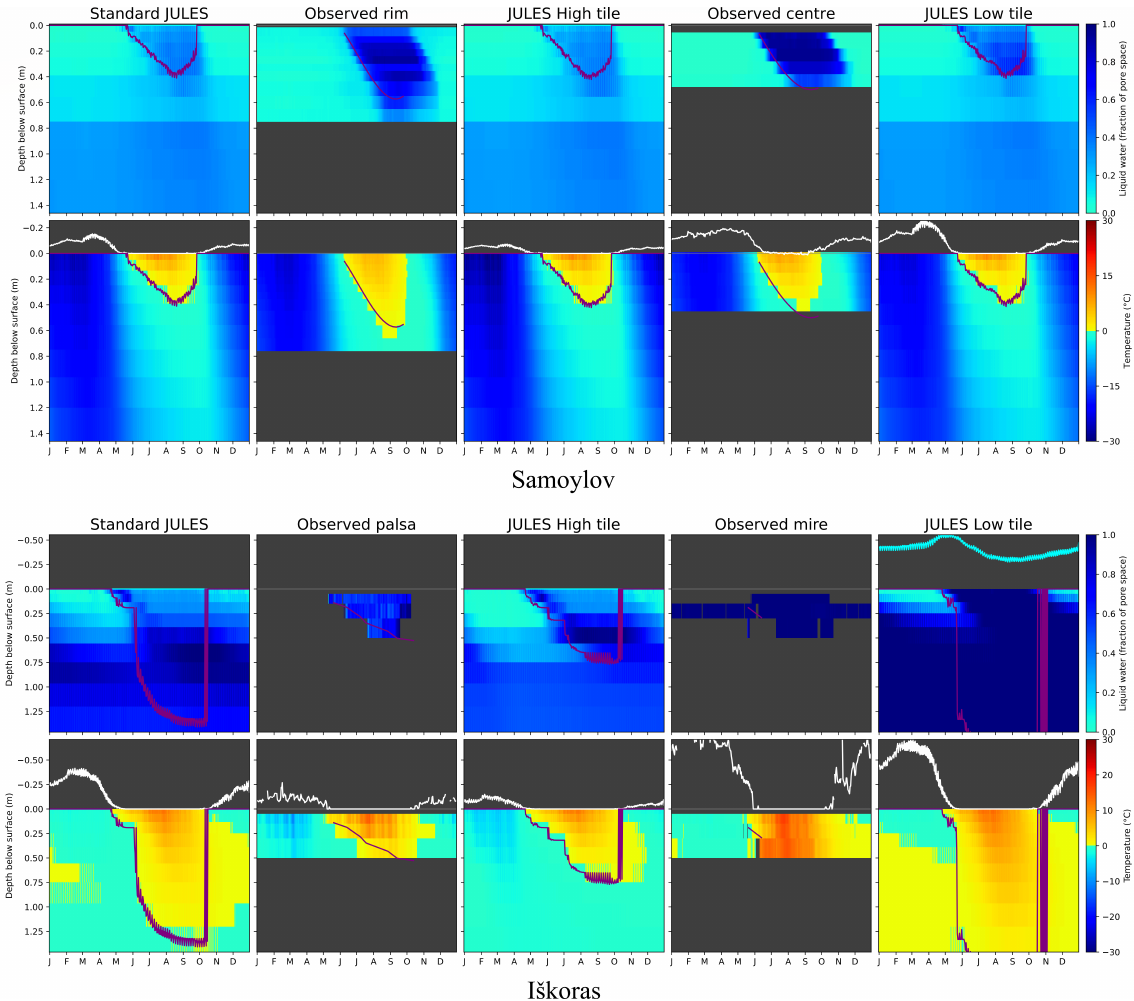
Figure 5. Climatologies (2002–2016) providing a comparison of observations with standard and tiled (no qbase) JULES for the polygon site Samoylov and the palsa site Iškoras. The white line above the plots of soil temperature shows snow depth, the cyan line above the plots of simulated soil moisture shows simulated pond depth, and the purple line shows thaw depth. Time series observations are not available for the rim at Samoylov. Figure B6 in Appendix B shows similar overviews for Kytalyk and Stordalen, although these are without observations.